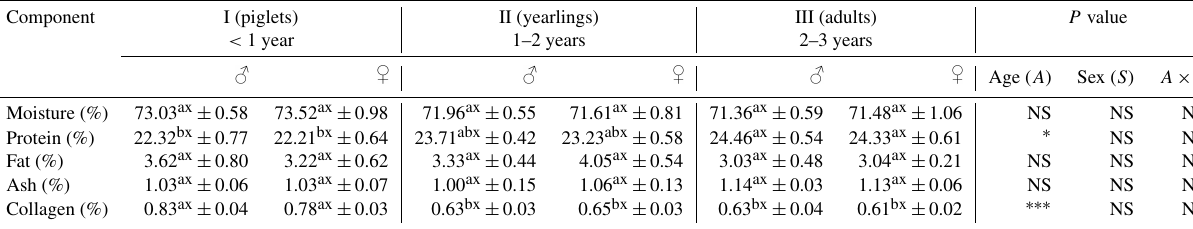
Table 6. Chemical composition of wild boar loin (longissimus thoracis et lumborum) muscle (mean ±